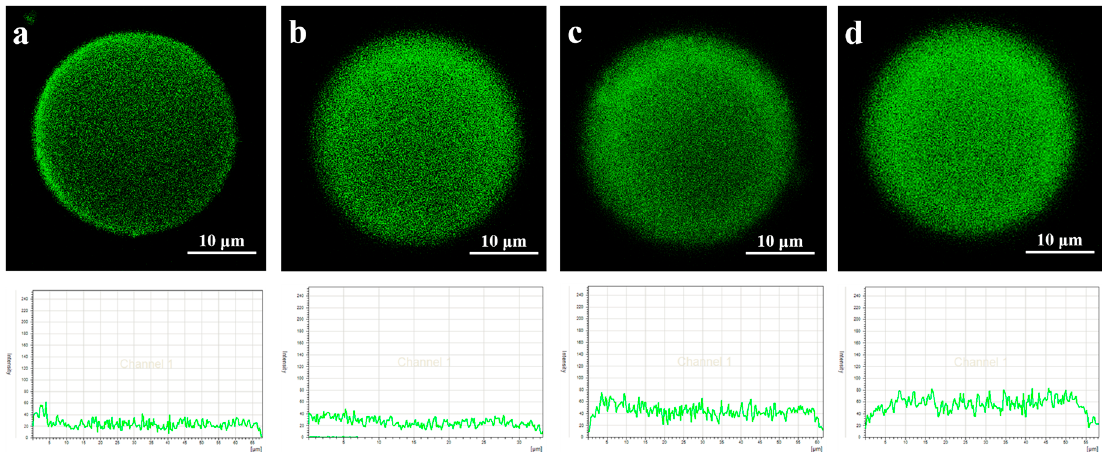
Figure 4. CLSM images and fluorescence distribution of lipase adsorbed in gigaporous microspheres at different time point (( a ) 2 min; ( b ) 8 min; ( c ) 30 min; ( d ) 40 min).